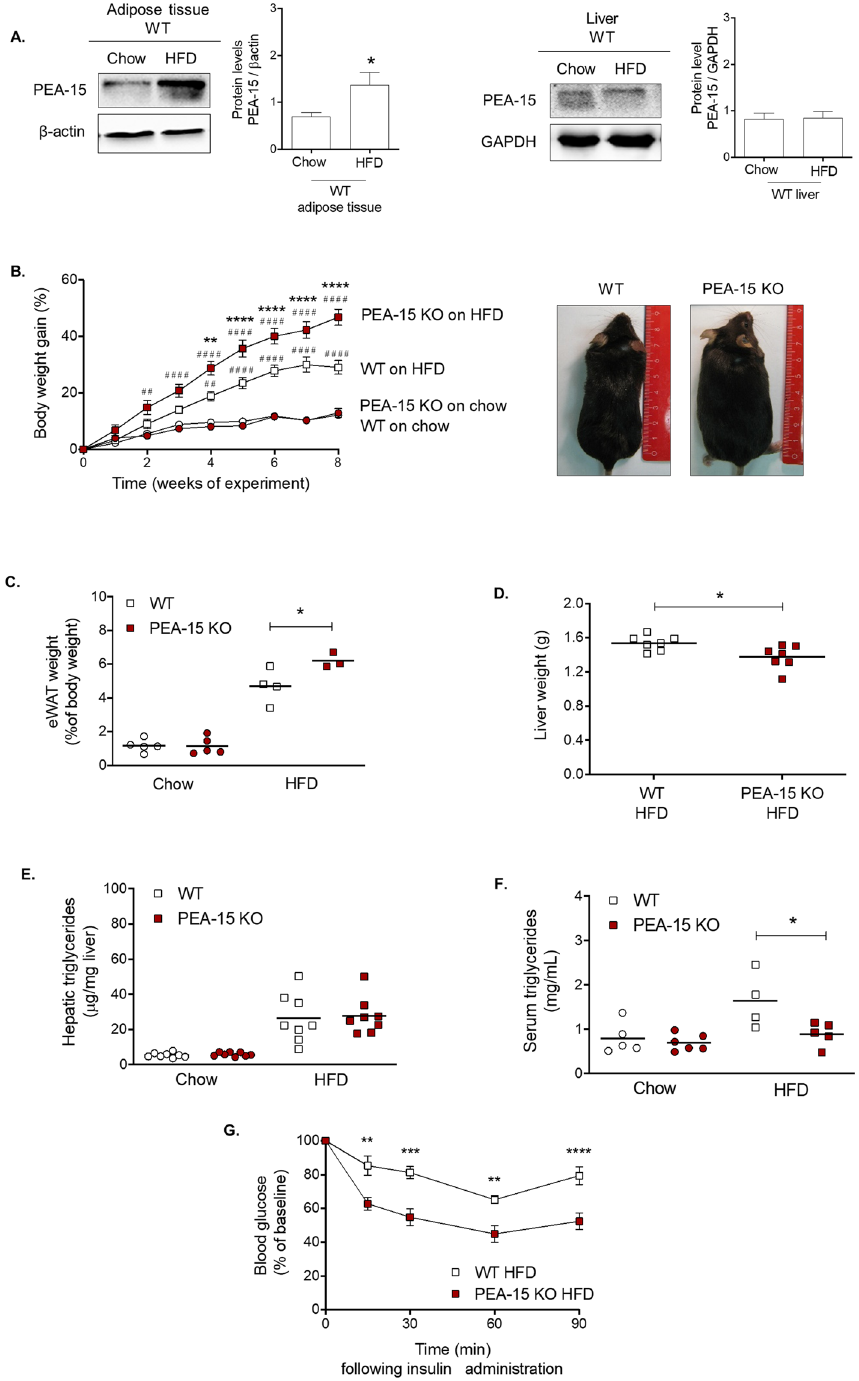
Figure 1. Characterisation of PEA-15 knockout (KO) mice. ( A ) Representative immunoblots for protein levels of PEA-15 in eWAT and liver samples of WT mice after 8 weeks of chow or HFD. Graph displays protein band quantification of PEA-15 as mean ± SEM, expressed as a ratio of β–actin or GAPDH, n = 4–5. *P < 0.05 using Student t test. Full immunoblot images are shown in supplementary Fig. 5. ( B ) Mean body weight gain of PEA-15 KO mice and WT. Gross morphology of WT and PEA-15 KO mice after 8 weeks of HFD. **P < 0.01 and ****p < 0.0001 when comparing genotypes and ##p < 0.01 and ####p < 0.0001 when comparing diets using two-way ANOVA and Bonferroni post hoc test, n = 8. ( C ) Weights of eWAT after 8 weeks of HFD. *P < 0.05 using two-way ANOVA and Bonferroni post hoc test. Significance between WT chow and WT HFD (p < 0.05) is not indicated in graph. ( D ) Livers were weighted directly after dissection after week 8 of the diet intervention, n = 7, *p < 0.05 using Student t test. ( E ) Triglyceride content was measured in liver (n = 8). *P < 0.05 when using two-way ANOVA and Bonferroni post hoc test. Significance between chow and HFD (p < 0.05) is not indicated in graph. ( F ) Triglyceride content was measured in serum (n = 4–6). *P < 0.05 when using two-way ANOVA and Bonferroni post hoc test. Significance between chow and HFD (p < 0.05) is not indicated in graph. ( G ) ITT assay on fasted (5 h) mice after 11 weeks of HFD. Graph shows glucose concentration as the mean ± SEM. **P < 0.01, ***p < 0.001 and **** p < 0.0001 using two-way ANOVA and Bonferroni post hoc test, n = 6–7. Area under the curve (AUC) calculations of graph in G of blood glucose levels. ***P < 0.001 using Student t test, n = 6–7. All graphs were produced using GraphPad Prism version 9.0.0 for Windows, GraphPad Software, San Diego, California USA, www. graph pad.